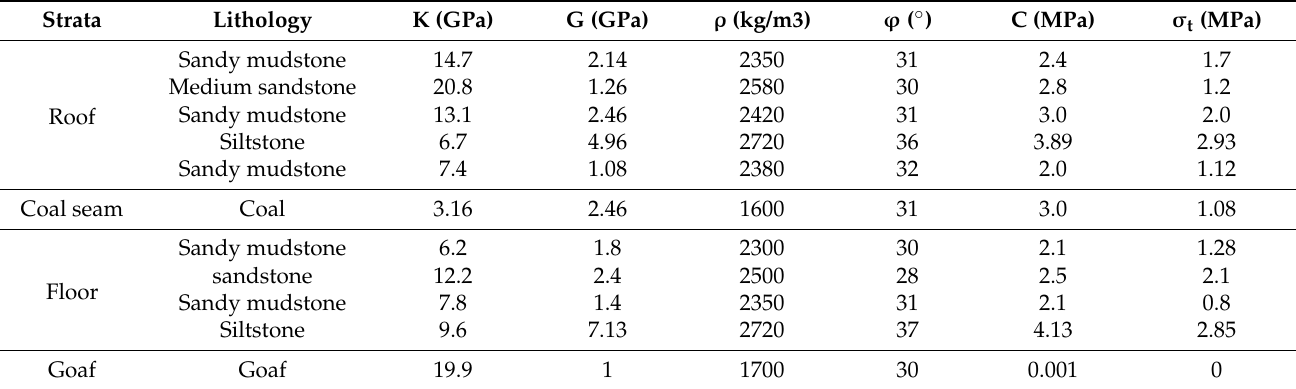
Figure 1. FLAC3D model diagram. Table 1. Rock mechanical properties of modeled materials.